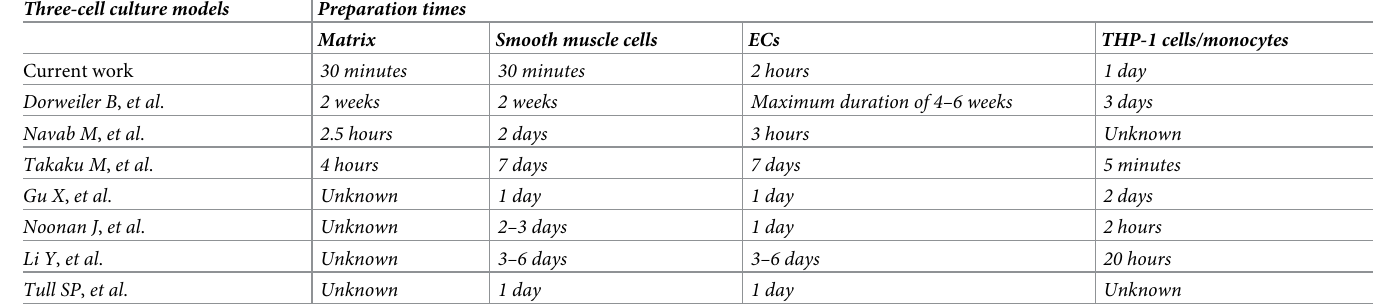
Table 1. Comparison of preparation time of three-cell co-culture models of atherosclerosis. Three-cell culture